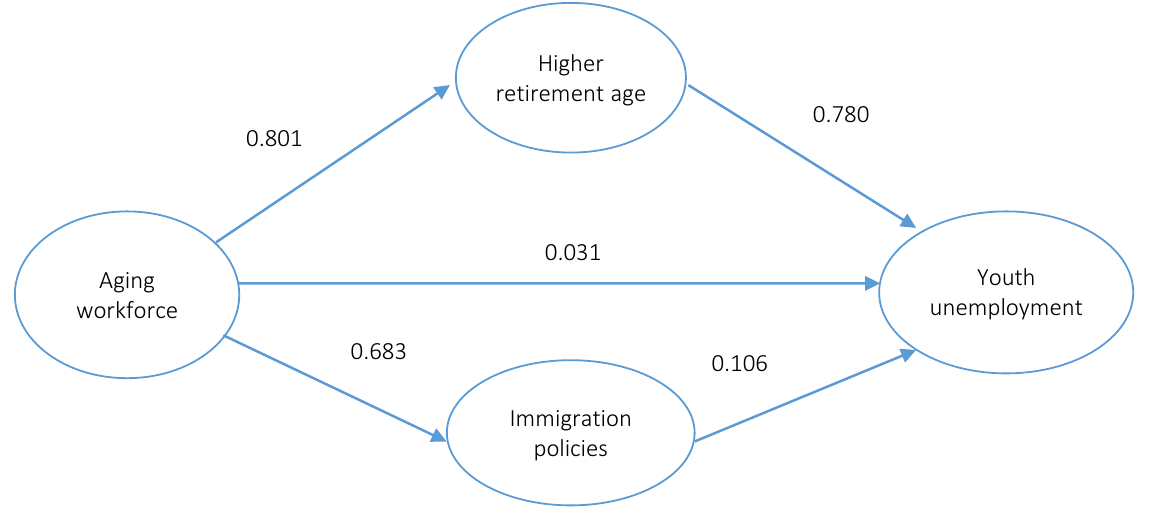
Figure 2. Findings from the structural model